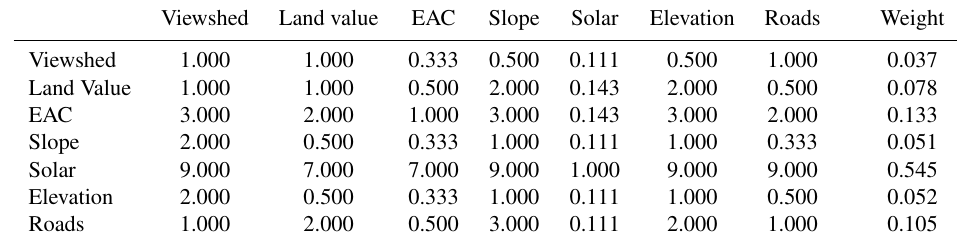
Table 3. Case 2: pair-comparison matrix and relative importance weights in the last column.